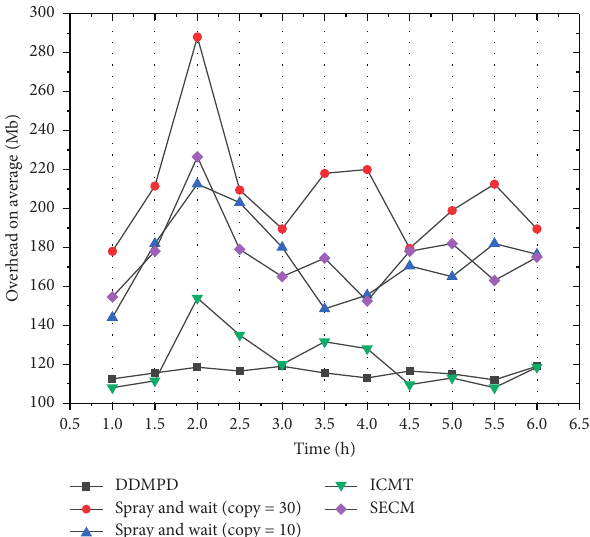
Figure 8: Relationship between average overhead and